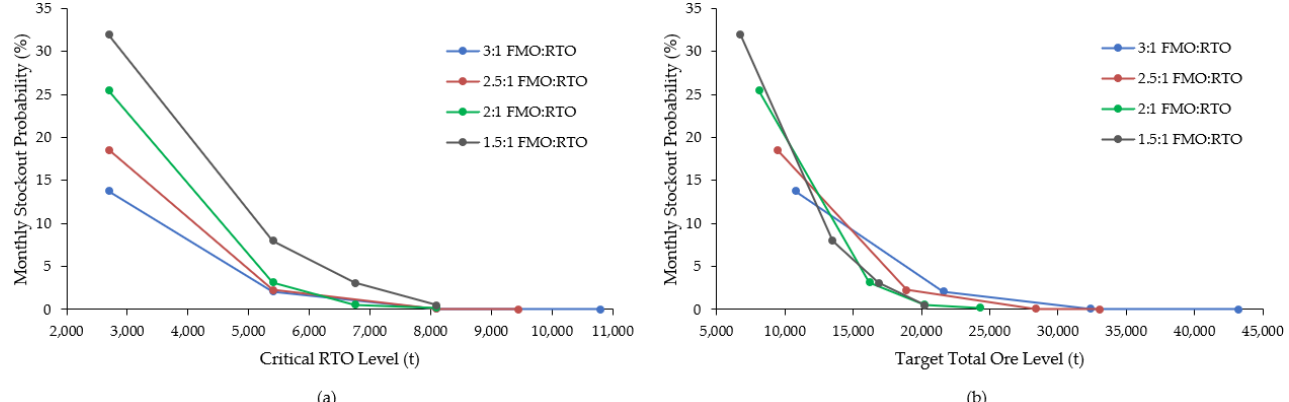
Figure 10. Plots of monthly stockout probability (%) versus ( a ) critical RTO level and ( b ) target total ore level for a variety of simulated ore type ratios over 100 statistical replications.